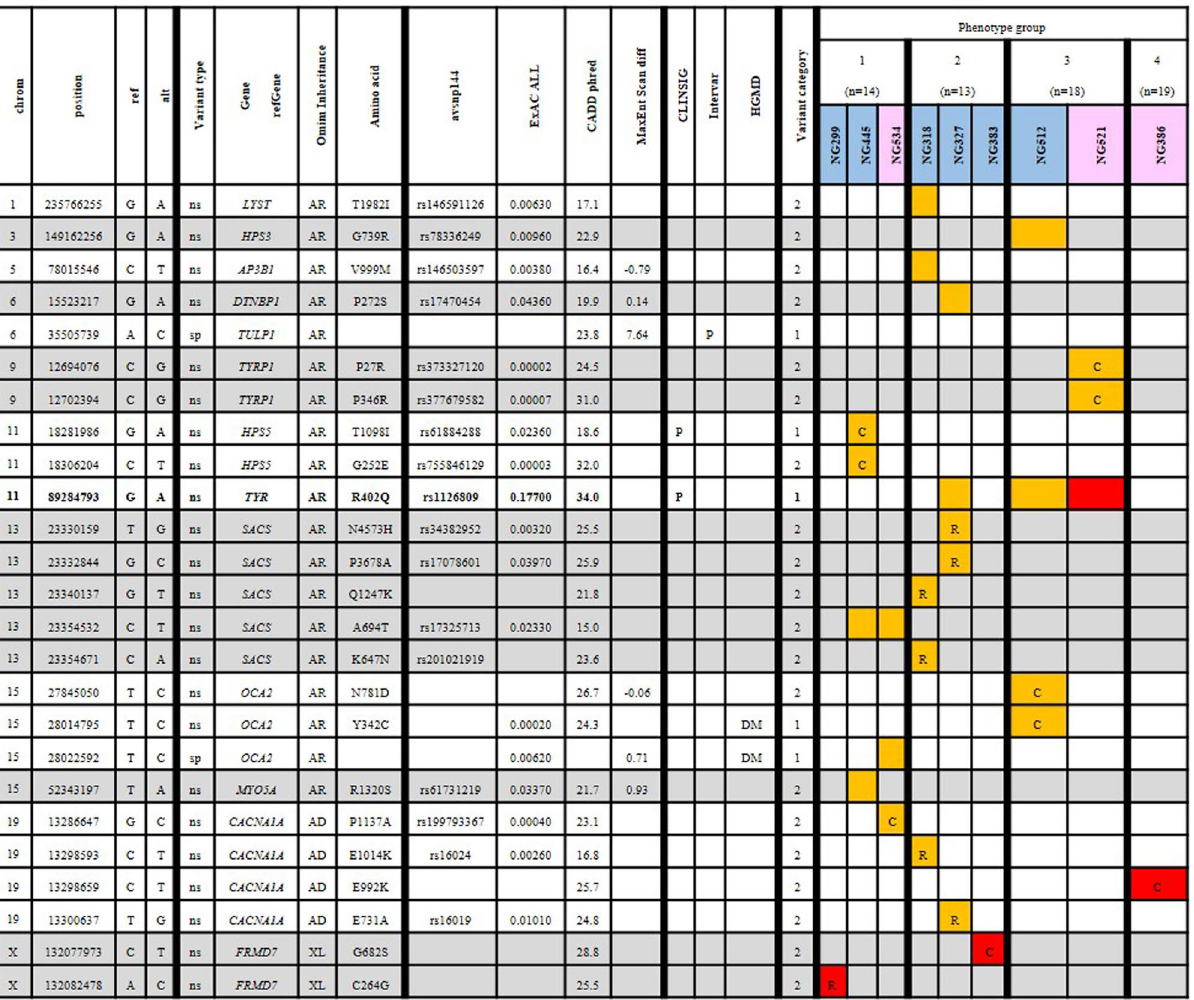
Figure 2. Nine patients with assumed likely pathogenic variants determined to be likely causal. For 64 patients investigated for likely causal genotypes by investigating variants which were assumed likely pathogenic or as a combination of assumed pathogenic and assumed likely pathogenic, 13 patients were determined to have likely causal genotypes. Samples, blue background indicates male whilst pink indicates female, orange cells indicate heterozygous variants and red indicates homozygous variants. Samples are ordered by phenotypic group, and cells with a ‘C’ denotes a likely causal variant,‘R’ denotes a reportable variant, ‘-’ denotes variant miscall. Chrom, chromosome; Position, location of 5 ′ base of variant in hg38; Ref, reference allele; Alt, alternative allele; Variant type, consequence of the variant (s = synonymous, ns = nonsynonymous, sp = splicing, sg = stopgain); Gene. refGene, gene symbol; Omim Inheritance, inheritance as listed on OMIM for the gene in OCA/nystagmus; Amino acid, amio acid change; avsnp144, dbSNP144 rsID; ExAC ALL, Alternate allele frequency from ExAC database (all populations); CADD Phred, Combined Annotation Dependent Depletion score (Phred scale); MaxEntScan diff, the difference in score between MaxEntScan reference allele and alternative allele; ClinSig, clinical significance (clinvar) annotated ‘p’ if ‘pathogenic’; InterVar, annotated as ‘p’ if identified as ‘pathogenic’ by InterVar; HGMD 2016 CLASS, annotated as DM for disease-causing mutation; Variant category, 1 = assumed pathogenic, 2 = assumed likely